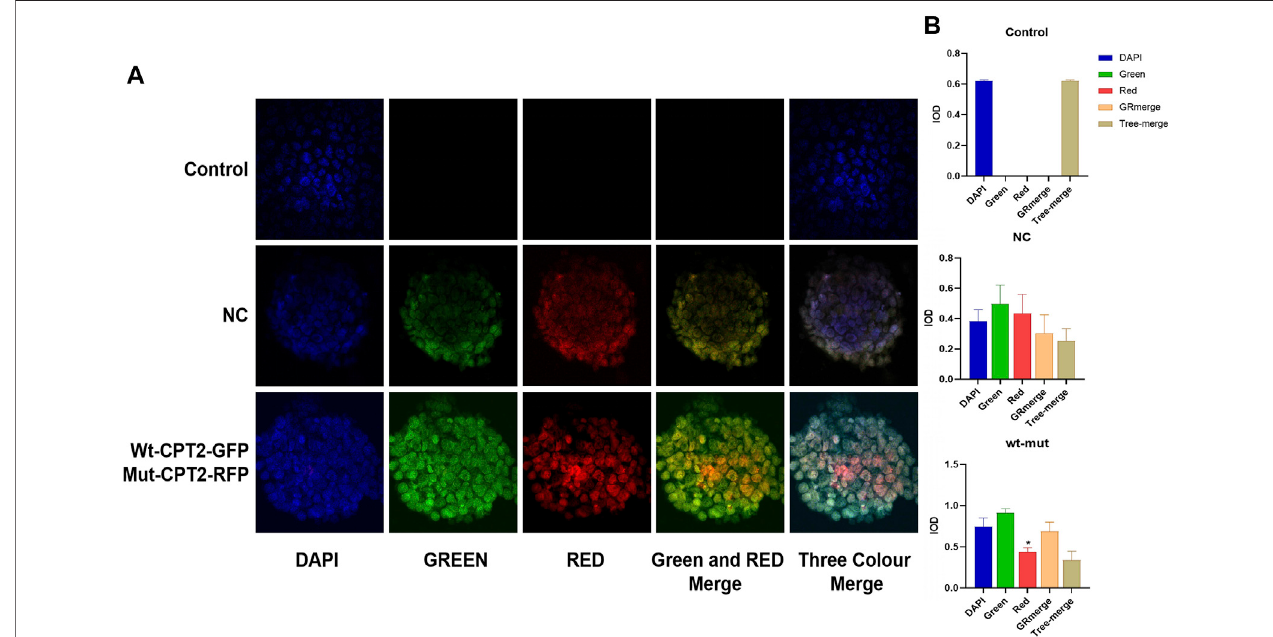
FIGURE3| Missensevariantp.R631ConthesubcellularlocalizationofCPT2proteinunderconfocalmicroscopy. (A) .Thevectorsdrovetheexpressionofthewild- type protein in association with GFP protein tag (WT-CPT2-GFP) as well as the mutant variants fusion with RFP fusion protein for identi fi cation (Mut-CPT2-GFP). The CPT2 protein was mainly localized in the nucleus, partly distributed in the cytoplasm. The fl uorescence signal showed that there was no overt subcellular mislocalization of the p.R631C mutant with respect to wild-type CPT2. (B) . The fl uorescence intensity of p.R631C mutants was obviously reduced than wild-type protein.